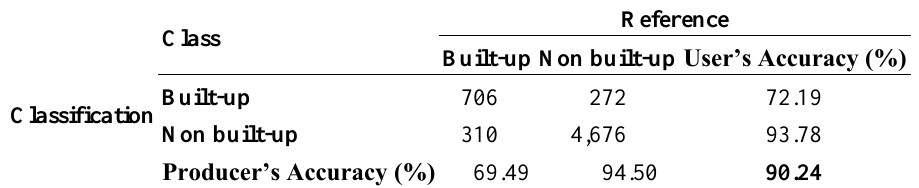
Table 3. Error matrix for the built-up mask, which has been extracted from